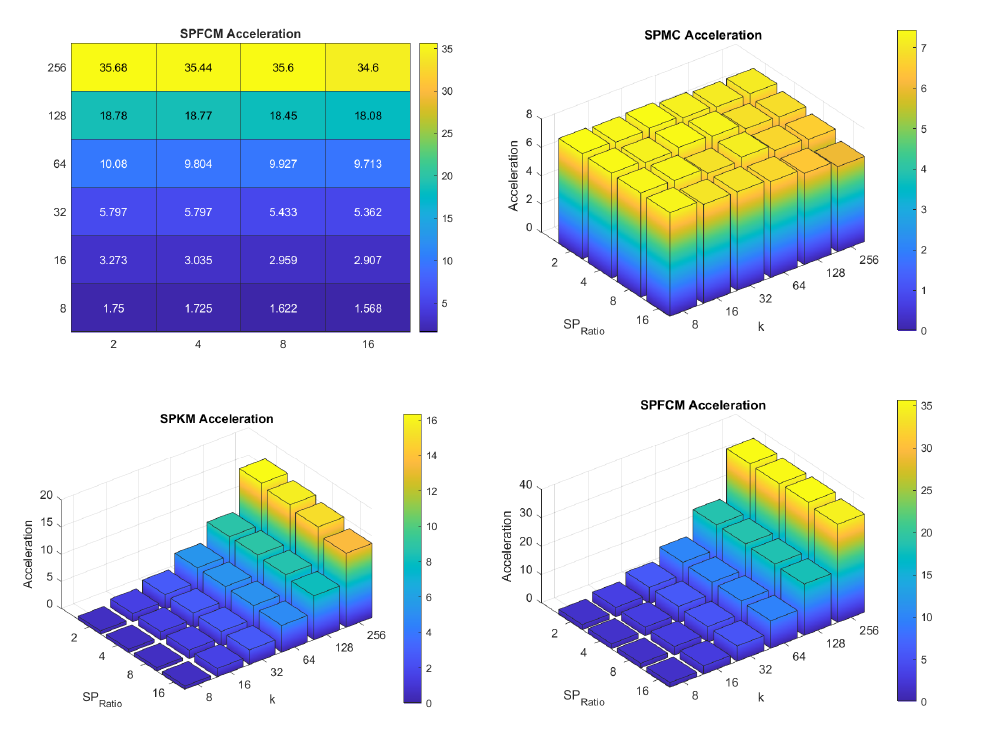
Figure 7. Computation rates of superpixel CQ algorithms relative to the corresponding pixel algo-